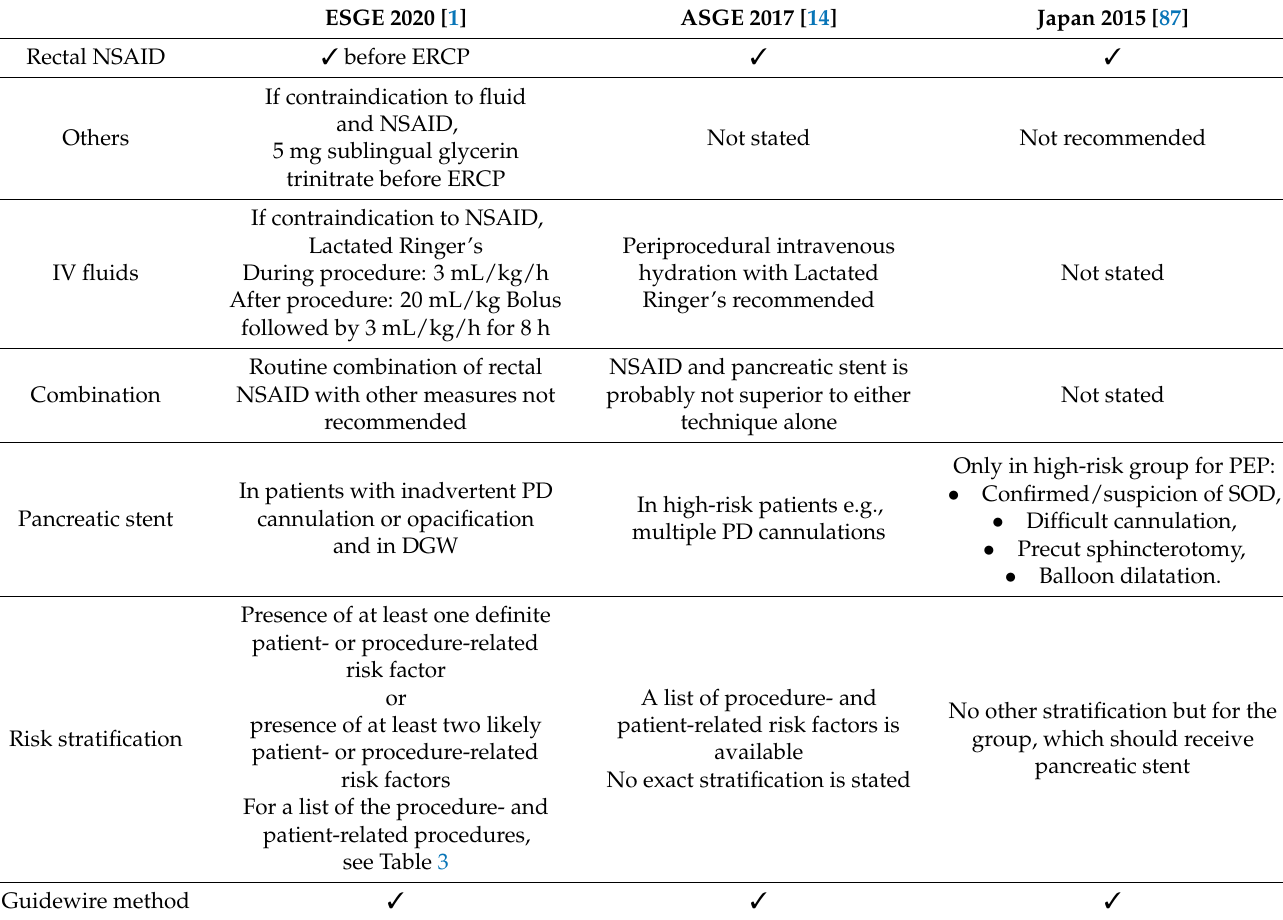
Table 4. Summary of international guidelines on PEP